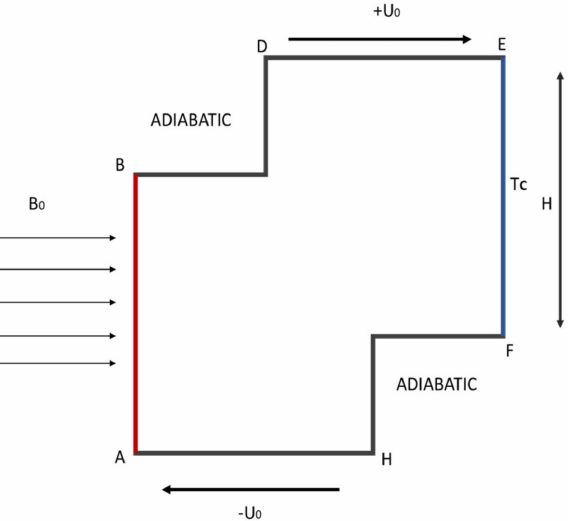
Figure 1. Illustration of 2D Darcy-Forchheimer flow through a vertical Cleveland Z-staggered